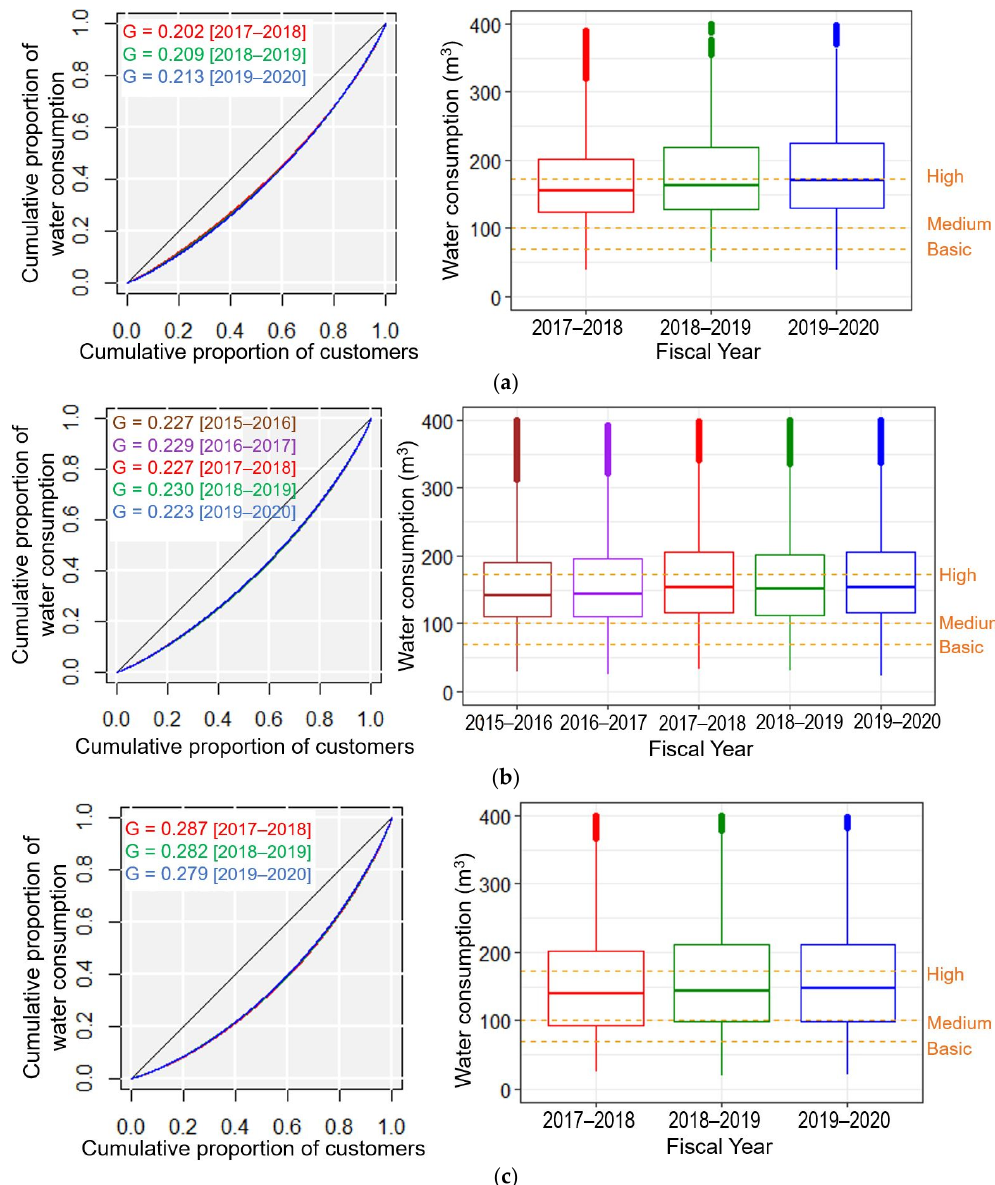
Figure 9. Lorenz curve ( left ) and volume ( right ) of yearly consumption: ( a ) Birat, ( b ) Lekhnath, and ( c ) Kakarvitta. The customers’ yearly water consumption volume slowly increased during the study period; Birat’s three years (mean = 169.7–184.1, and median = 155.0–171.3), Lekhnath’s five years (mean = 156.8–167.5, and median = 142.0–155.0), and Kakarvitta’s three years (mean = 156.8–165.1, and median = 140.0–148.0). Considering the average household size of 4.2 for urban areas, minimum water consumption amounts of 68.98, 99.64,